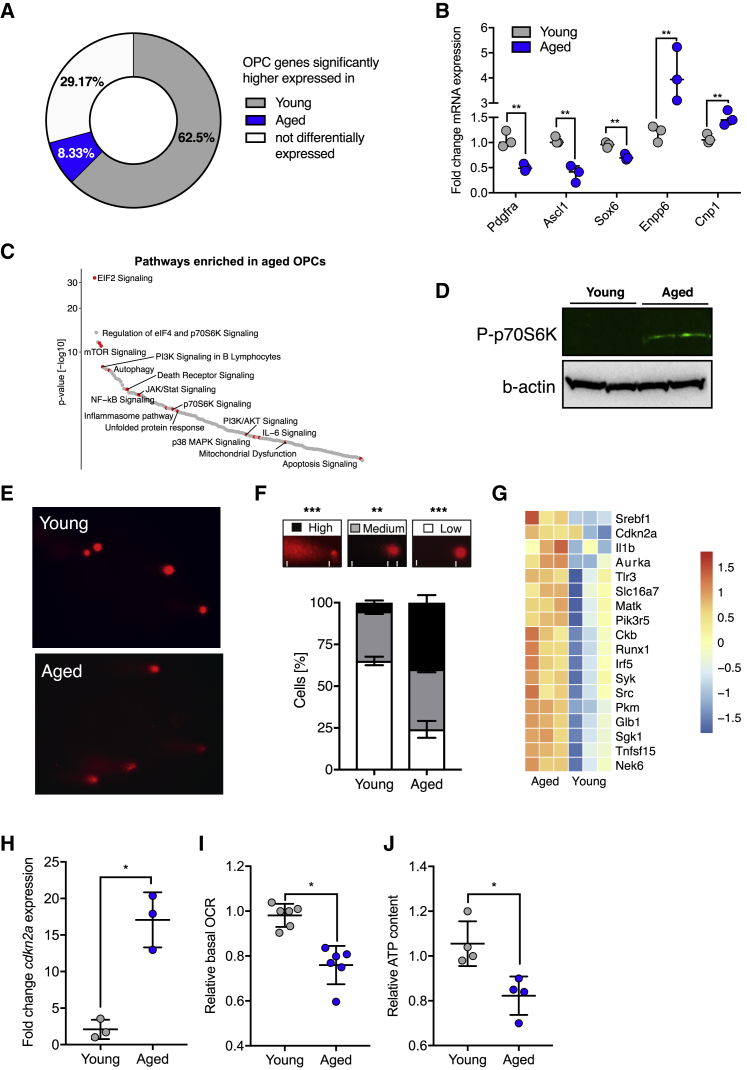
Aged OPCs Have Reduced Expression of OPC-Specific Genes and Acquire Hallmarks of Aging(A) Young and aged OPCs were tested for differential expression of OPC-specific genes. The pie chart summarizes the findings as the percentage of genes that were expressed at significantly higher levels in aged or young OPCs (p.adj < 0.05) or that were not differentially expressed (p.adj > 0.05). See also Table S1.(B) qRT-PCR validation of several genes identified in RNA-seq, comparing freshly isolated young and aged OPCs (n = 3 biological replicates for each age group, two-tailed t test).(C) Top 5 pathways identified by ingenuity pathway analysis (Z score > 2 and p.adj. < 0.05) for genes enriched in aged OPCs (p.adj < 0.05; see also Table S2).(D) Western blot for the downstream mTORC1 pathway target p70S6K and actin loading controls. P, phosphorylated; n = 2 biological samples for each age group.(E) Representative images for comet assays (alkaline conditions) of freshly isolated young and aged OPCs to visualize the degree of DNA damage. Presence of a tail indicates DNA damage.(F) Quantification of the comet assay. The categories used for scoring are depicted in the respective boxes. Statistical significance was determined using one-way ANOVA and Turkey’s post test. All data are presented as mean ± SD (n = 3 biological replicates for each age group).(G) Heatmap of genes from RNA-seq data whose expression is associated with cellular senescence. All depicted genes are differentially expressed (n = 3 biological repeats).(H) qRT-PCR results visualizing expression of the senescence marker Cdkn2a. Data are presented as mean ± SD (n = 3 biological replicates for each age group, two-tailed t test).(I) Fold change of the basal oxygen consumption rate (bOCR), measured after overnight culture in vitro (n = 3 biological repeats for each age group, two-tailed t test).(J) Normalized intracellular ATP content of freshly isolated OPCs (n = 5 biological repeats for each age group, two-tailed t test).Error bars represent SDs. ∗p < 0.05, ∗∗p < 0.01, ∗∗∗p < 0.001.